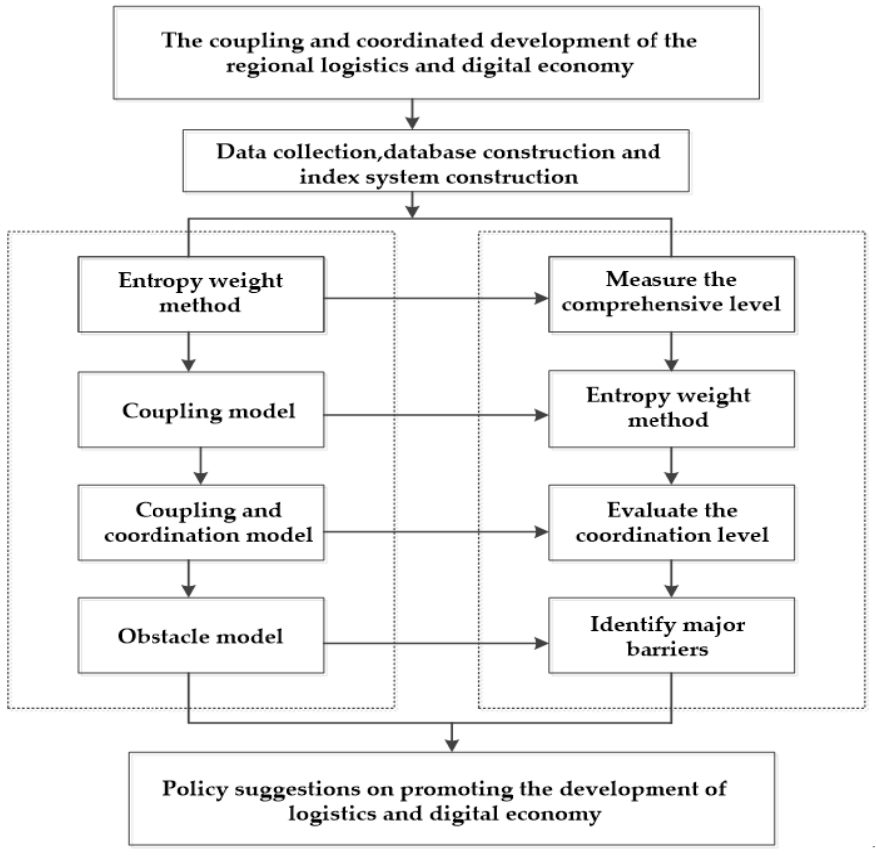
Figure 2. Data application diagram.